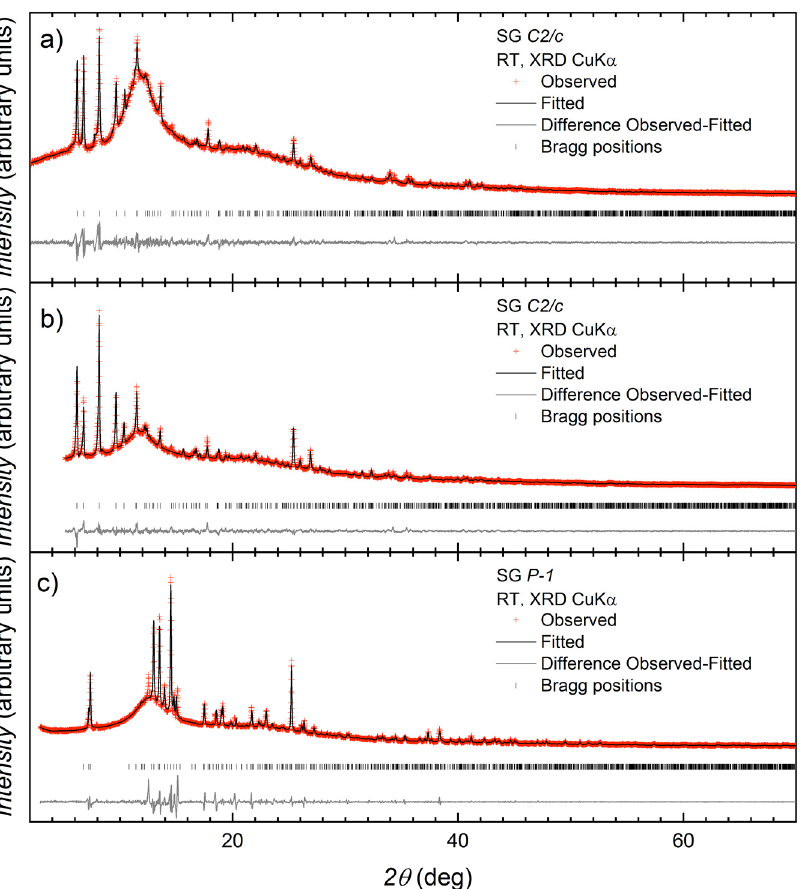
Figure 3. Laboratory X-ray di ff raction (CuK α 1 radiation) pattern (red crosses) of ( a ) the bulk crystalline material from experiment 2 with fitting to the predicted pattern from the single crystal determination of [{Cu 4 ( µ 3 -OH) 2 ( µ -OAc) 2 ( µ 3 -OAc) 2 (AcO- κ O) 2 ( 1 ) 2 } · 2MeOH] n ; ( b ) the bulk crystalline material from experiment 1 with fitting to the predicted pattern from the single crystal determination of [{Cu 4 ( µ 3 -OH) 2 ( µ -OAc) 2 ( µ 3 -OAc) 2 (AcO- κ O) 2 ( 1 ) 2 } · 2MeOH] n ; and ( c ) the crystalline material from the preparative scale synthesis with fitting to the predicted pattern from the single crystal determination of [Cu 2 ( µ -OAc) 4 ( 1 )] n at room temperature. The black line corresponds to the best fit from the profile matching refinement. Lower vertical marks denote the Bragg peak positions. The bottom line in each plot represents the di ff erence between experimental and calculated points.